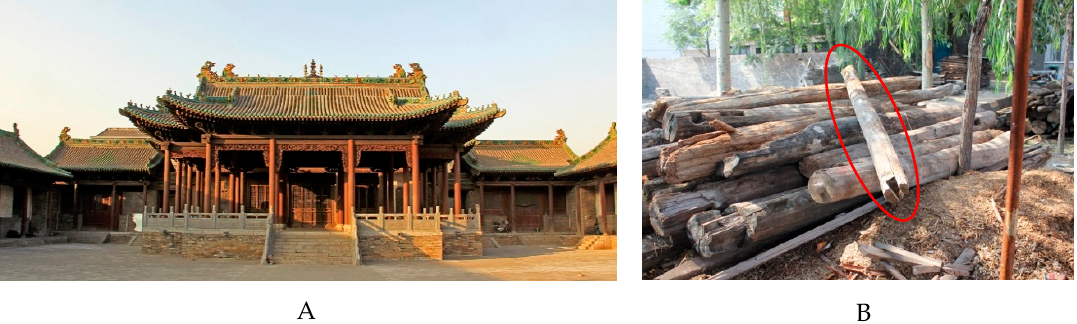
Figure 1. Chenghuang Temple ( A ) and the purlin-type beam ( B ) for this research. The beam in the red oval ( B ) was replaced from the old temple.